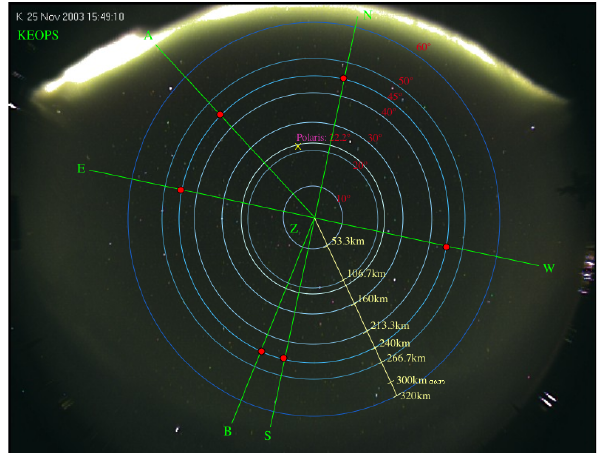
Fig. 9. All-Sky Camera image from KEOPS on the 25 Novem- ber 2003, showing an auroral arc to the north of KEOPS. Green lines show the look directions; red dots show the 630.0nm emit- ting volume presuming a 240km height; circles show other height distances.